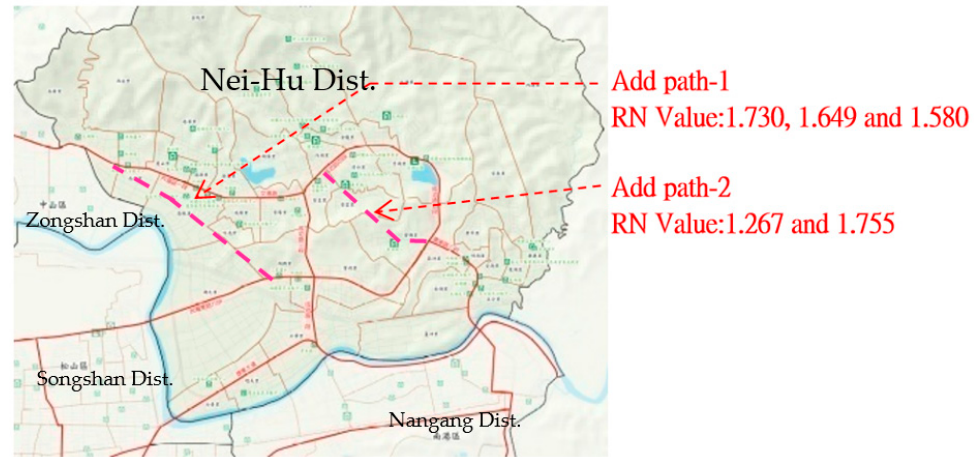
Figure 6. Added accessibility path.